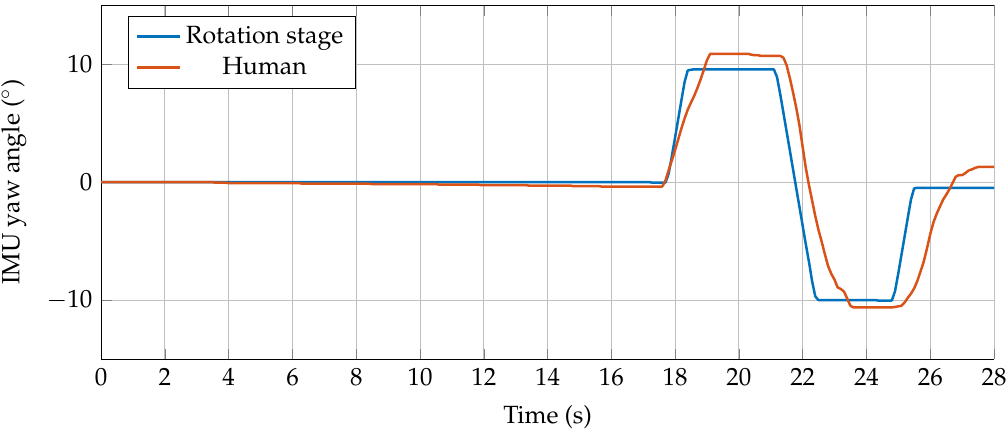
Figure 9. Test of human influence on the angle measurement. A motorized rotation stage simulated a head movement around the yaw axis. The human participant tried to replicate this movement. The measurement involving the human shows a drift at the beginning, which is not present in the motorized case. Despite slight deviations, which can be explained by the human doing an unconstrained movement, the measured angles are